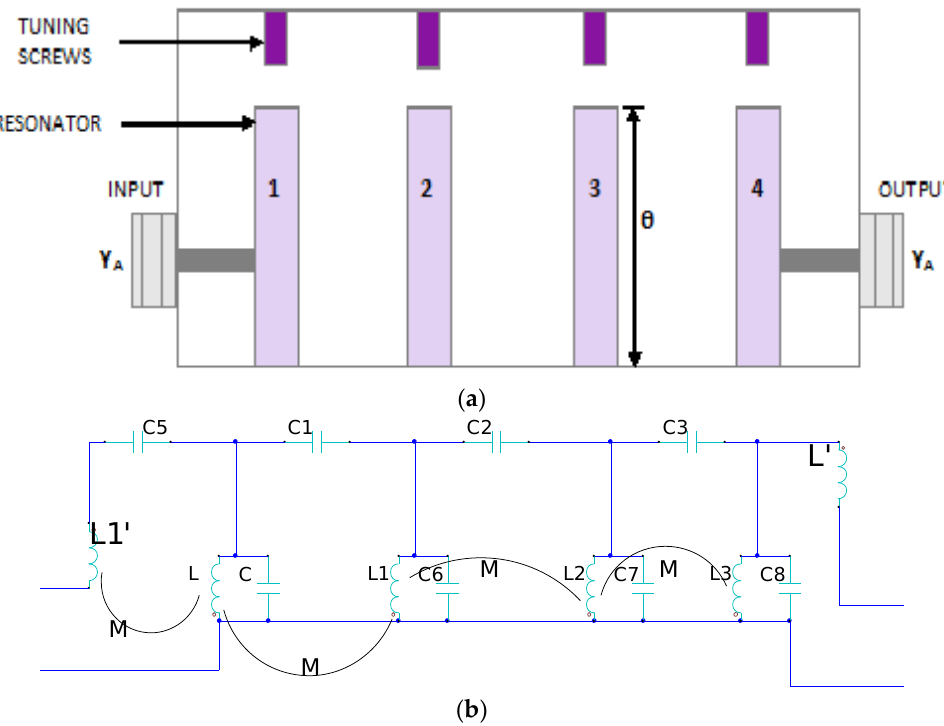
Figure 1. ( a ) General combline cavity filter and ( b ) Combline filter-equivalent circuit model.